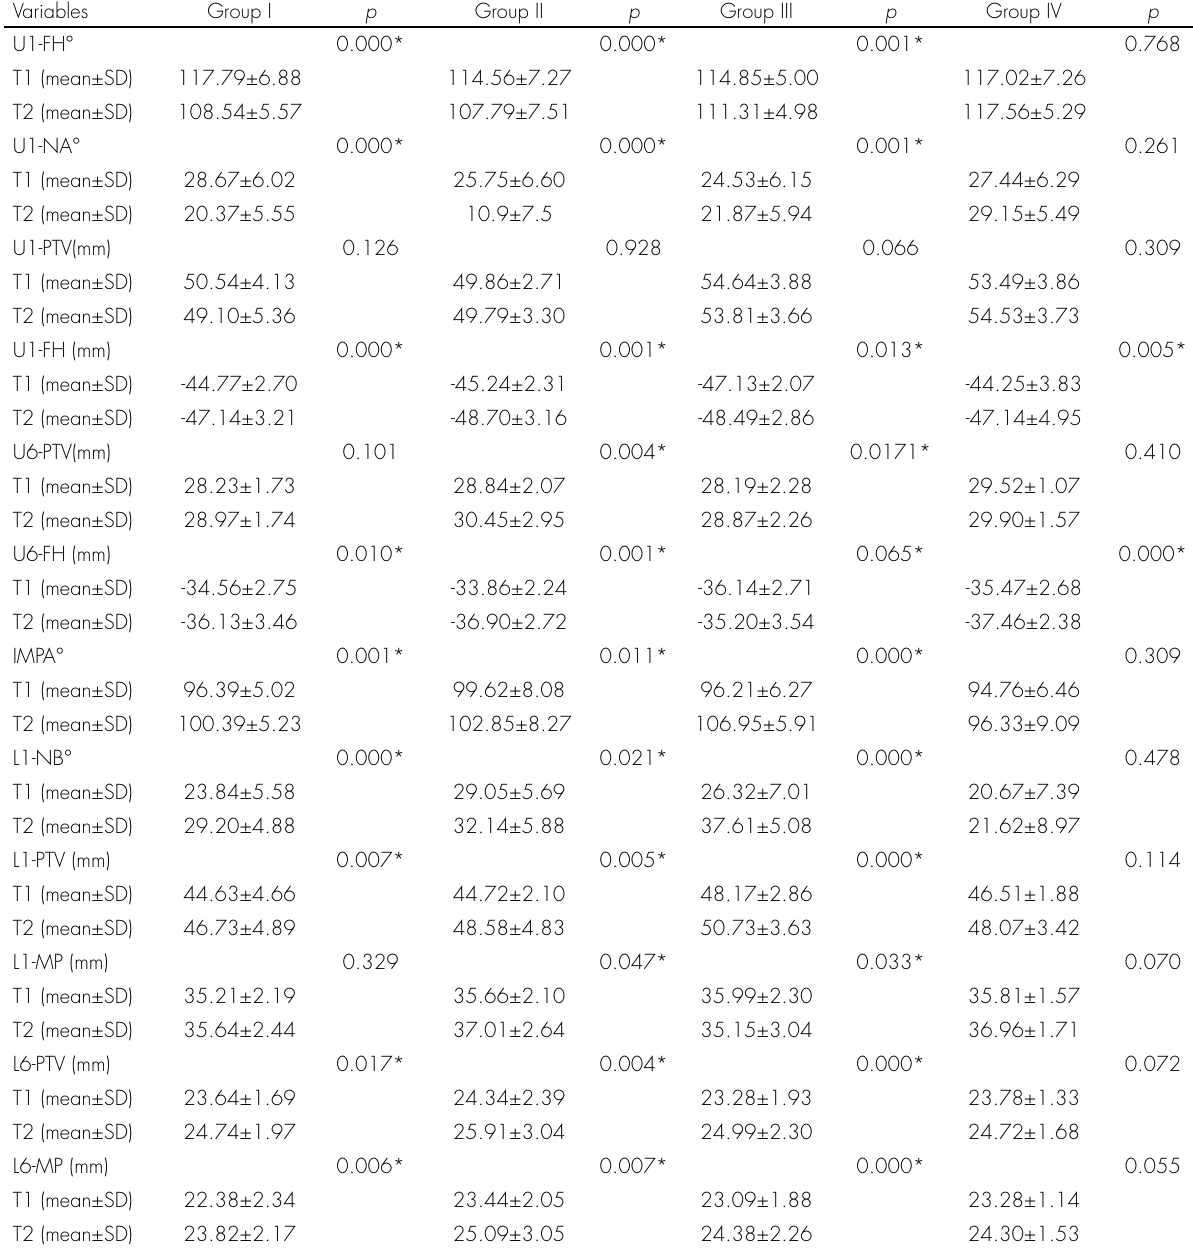
Table IV. Pre- (T1) and post-treatment (T2) dental measurements of each